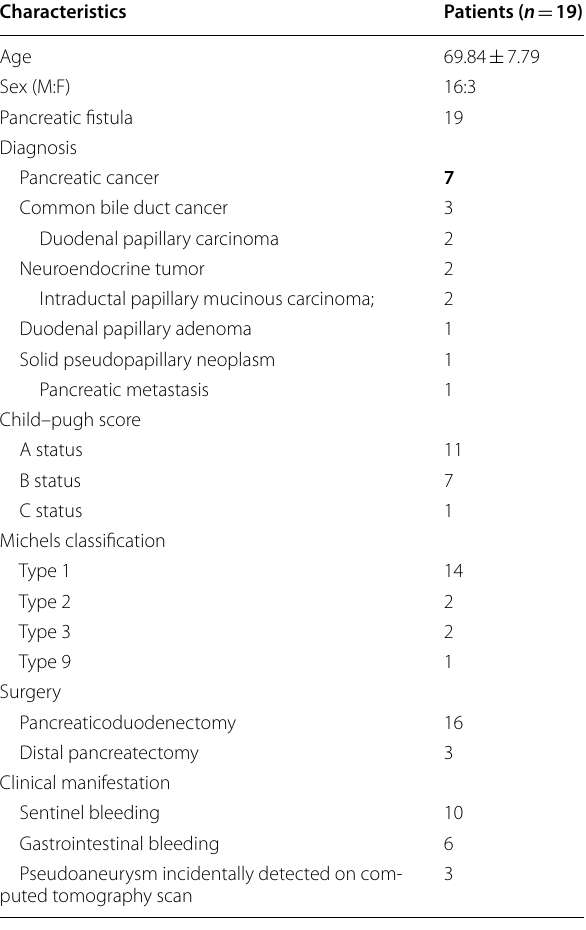
Table 2 Patient characteristics